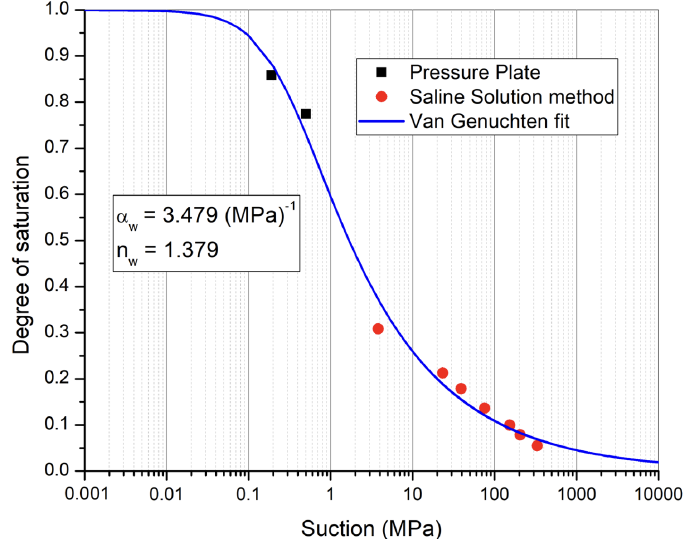
Figure 5. Soil water retention curve obtained from pressure plate and saline solution method using Van-Genuchten fitting